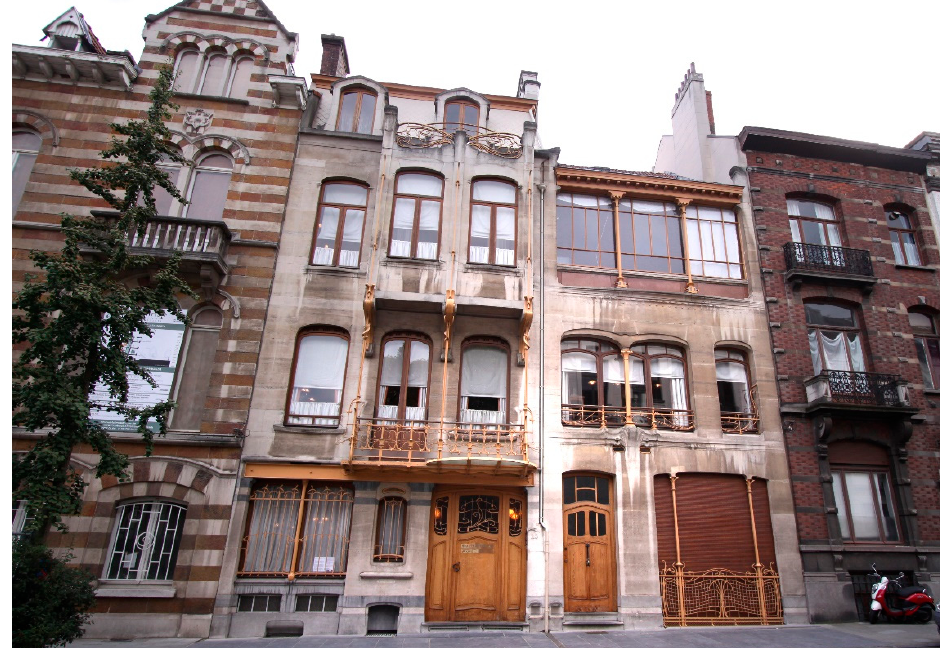
Figure 3 . The façade of the Horta House and Studio (Maison et Atelier